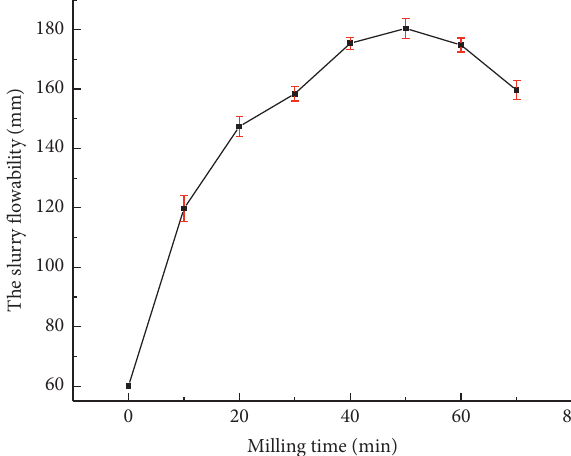
Figure 5: Variation of the slurry flowability of PBG with ball milling time.